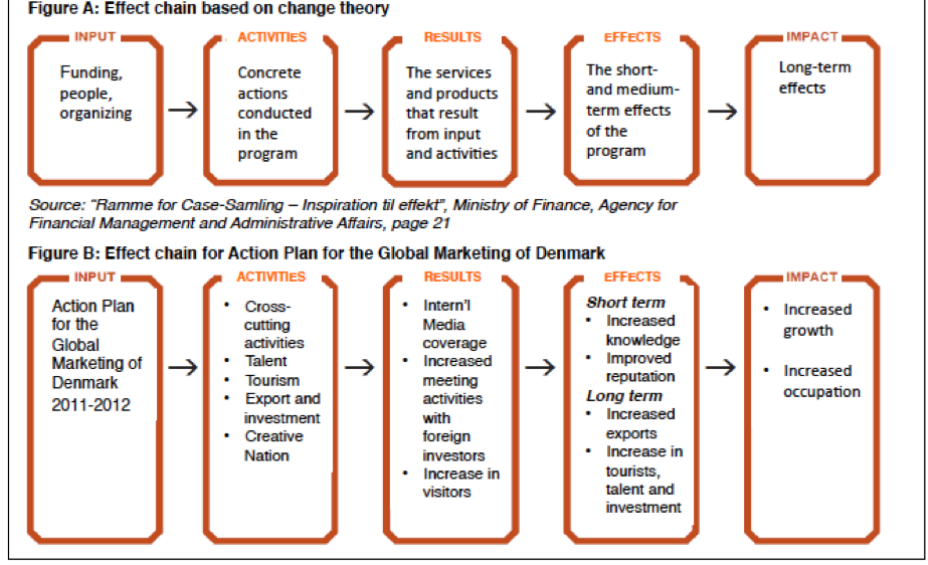
Table 2. The new “impact measurement method” devised in the last evaluation of the branding program (Danish Government, 2011, 11, our